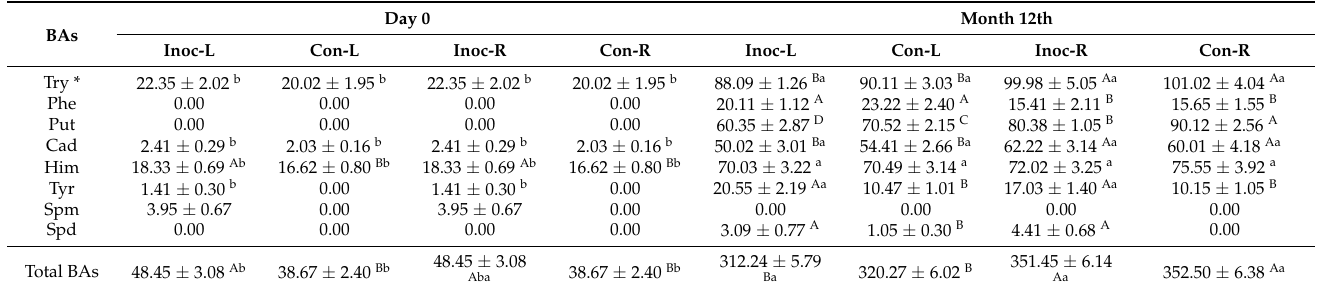
Table 4. Biogenic amines (BAs) of shrimp paste with/without B. subtilis K-C3 inoculation during storage for 18 months at low (4 ◦ C) and room (28 ◦ C)